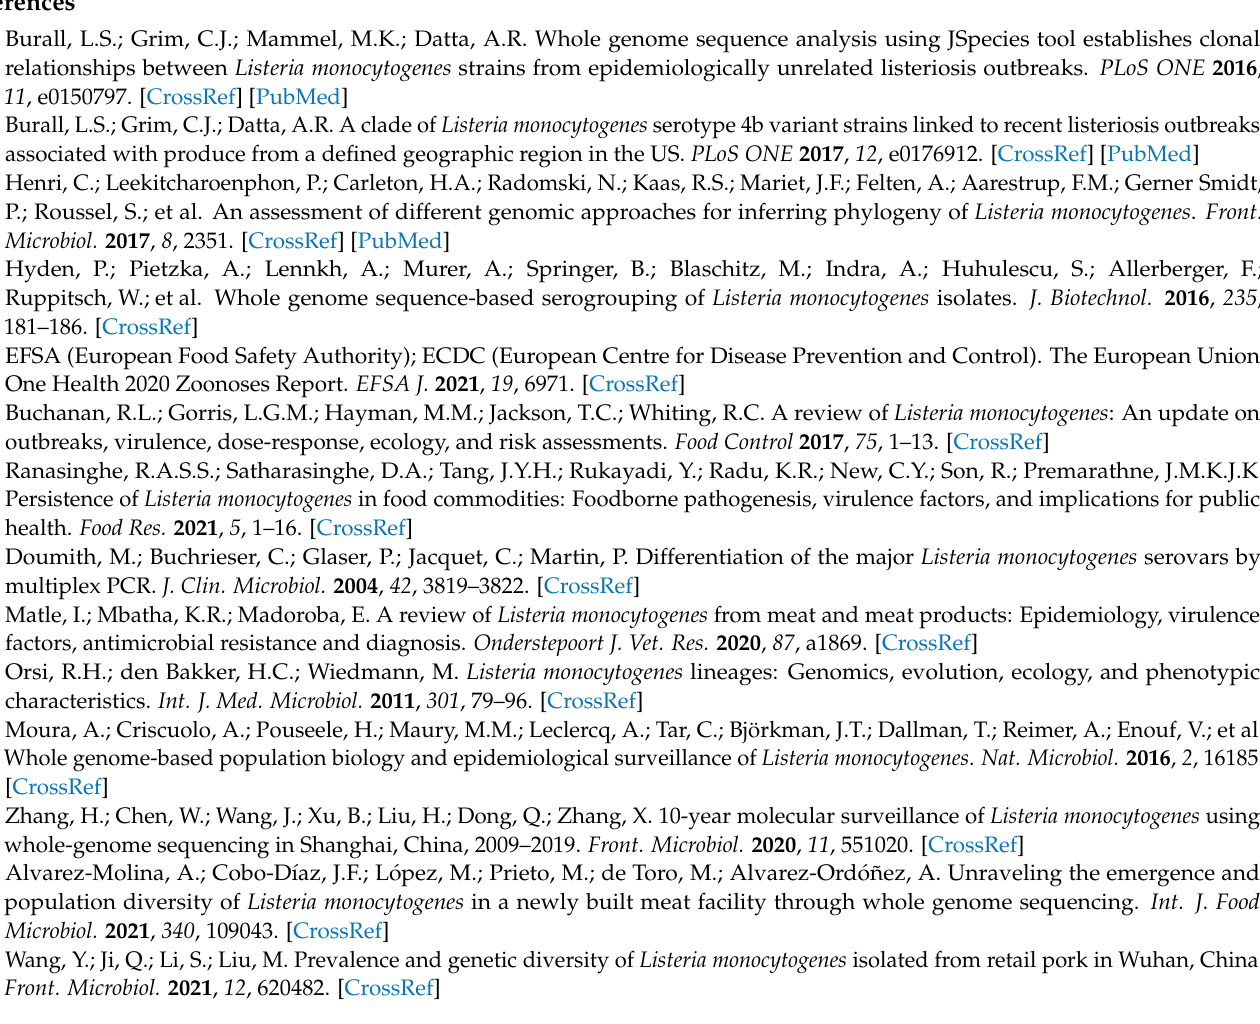
CC8 isolates; Table S1: Characteristics of L. monocytogenes isolates tested; Table S2: L. monocytogenes sequence parameters.; Table S3: L. monocytogenes isolates from Poland selected for comparison with the present strains; Table S4: Prophages and plasmids in Listeria monocytogenes strains